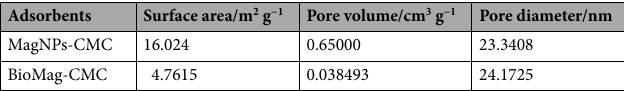
Table 2. Textural properties of MagNPs-CMC and BioMag-CMC.